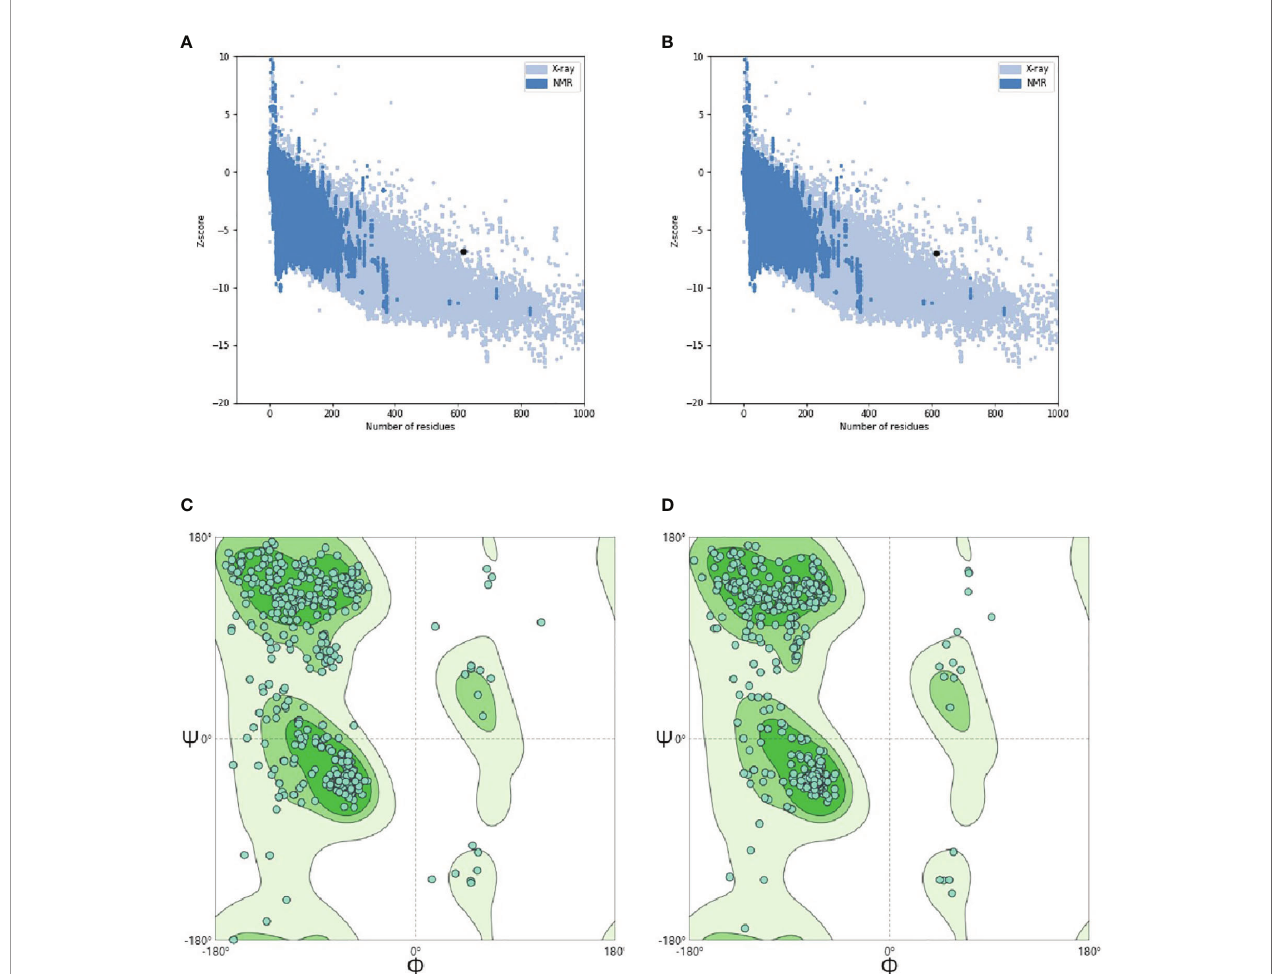
FIGURE 10 | Tertiary structure optimization and quality validation. (A) and (B) are the Z-score evaluation results. The abscissa represents the number of amino acids of the protein and the ordinate represents the score. The region formed by blue and gray blots in the fi gure are the reasonable scoring areas of the protein, and the black dot represents the target protein. The good target protein with the corresponding number of amino acids should fall in reasonable area. (C) and (D) are Ramachandran plot. In the fi gure, dark green is favored regions, green is additional allowed regions, light green is generously allowed regions and white is disallowed regions. The rationality of amino acid residues in these regions decreased in turn. When evaluating the quality of 3D model, it is hoped that the proportion of amino acid residues in favored regions is